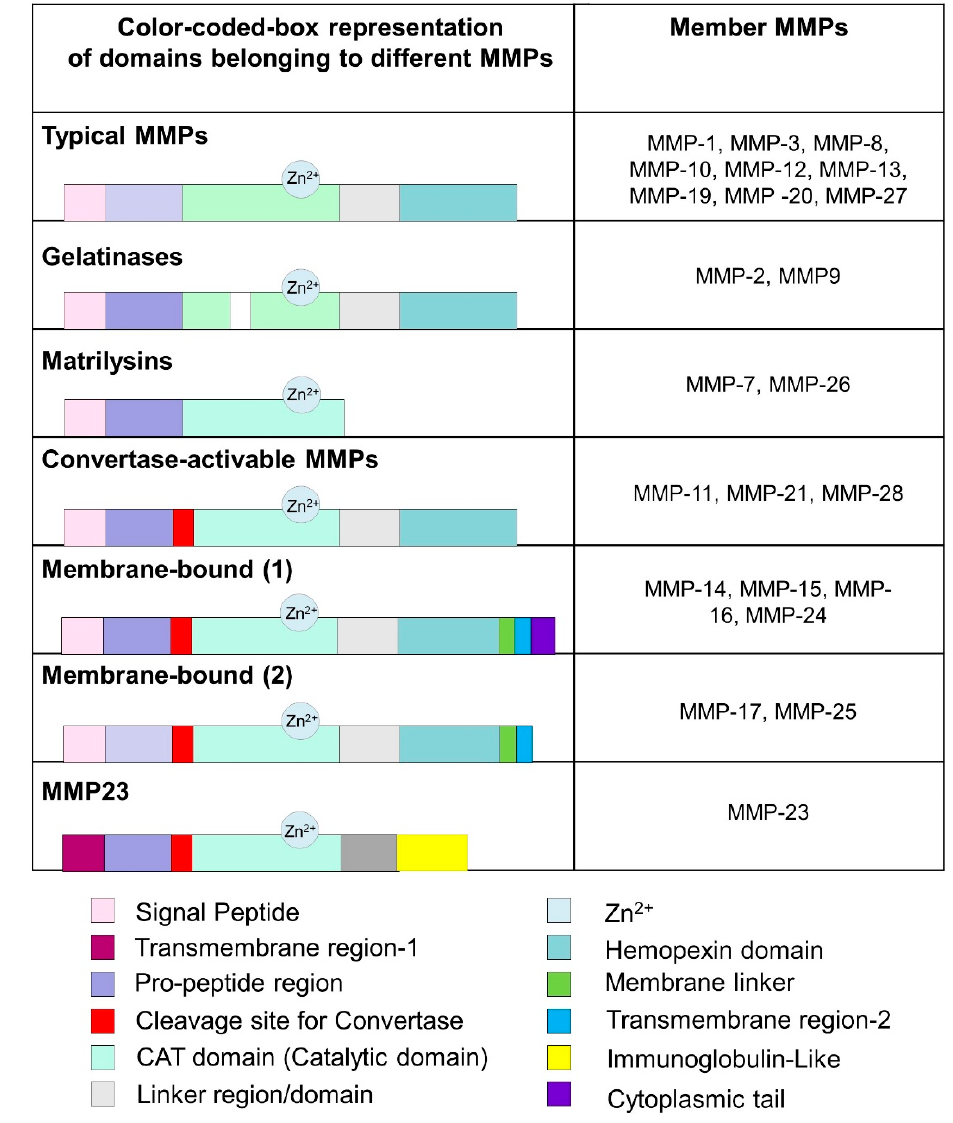
Figure 2. Schematic representation of the various domains of MMPs.